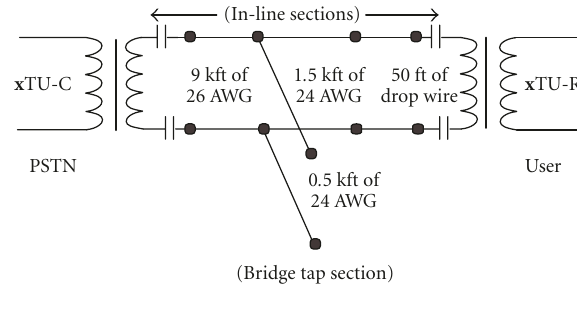
Figure 11: A typical end-to-end loop.